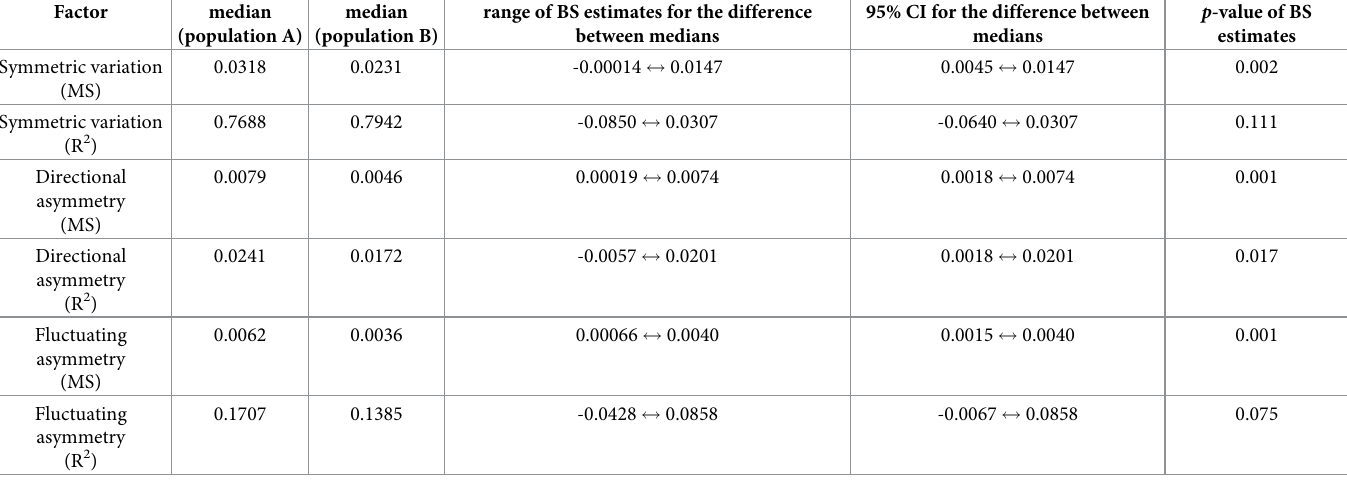
Table 3. Results of bootstrap tests for the difference in components of segment shape variation between populations represented by configurations slid by the mini- mum BE criterion. Factor median median range of BS estimates for the difference (population A) (population B) between medians